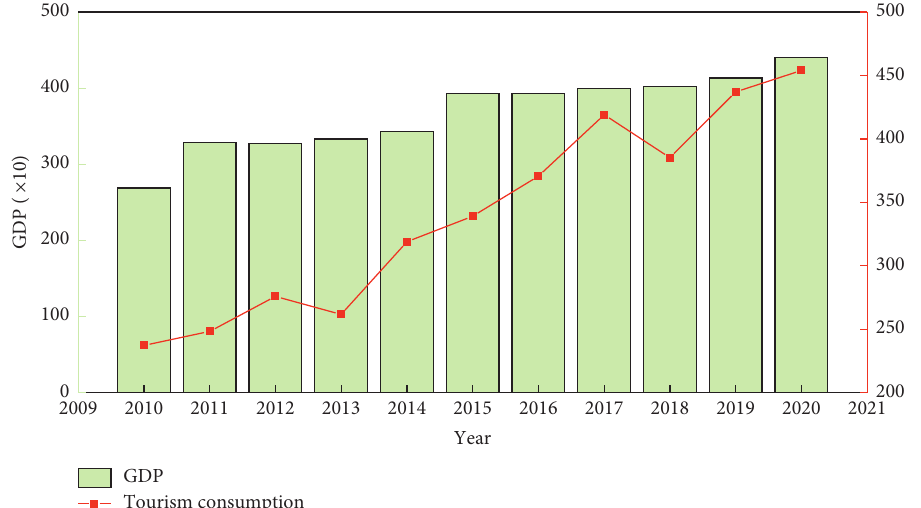
Figure 1: Relationship between GDP and tourism revenue.